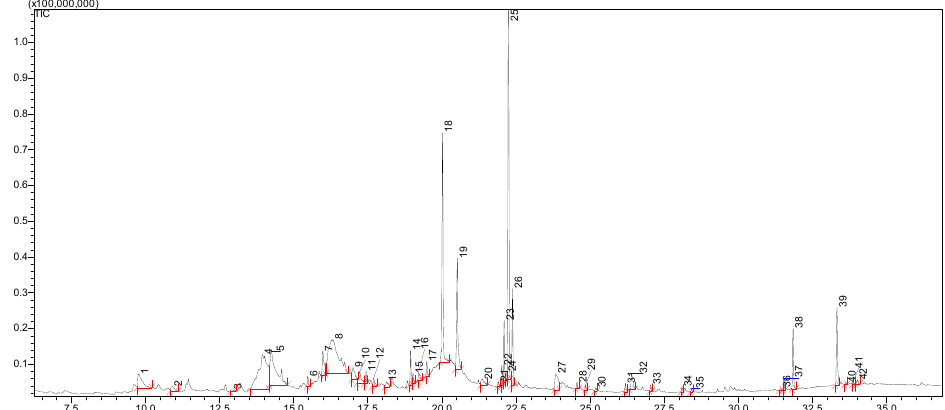
Figure 5. GC/MS chromatogram (in TIC mode) of C. hissaricus extract. Table 5. Composition of the extracts of leaves of C. hsingshangensis (% of total fraction; mass%, GC). No.